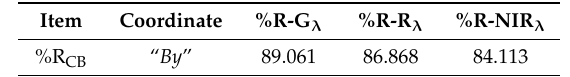
Table 9. Calibration bracket (CB) mean spectral reflectance values 1 per camera waveband.